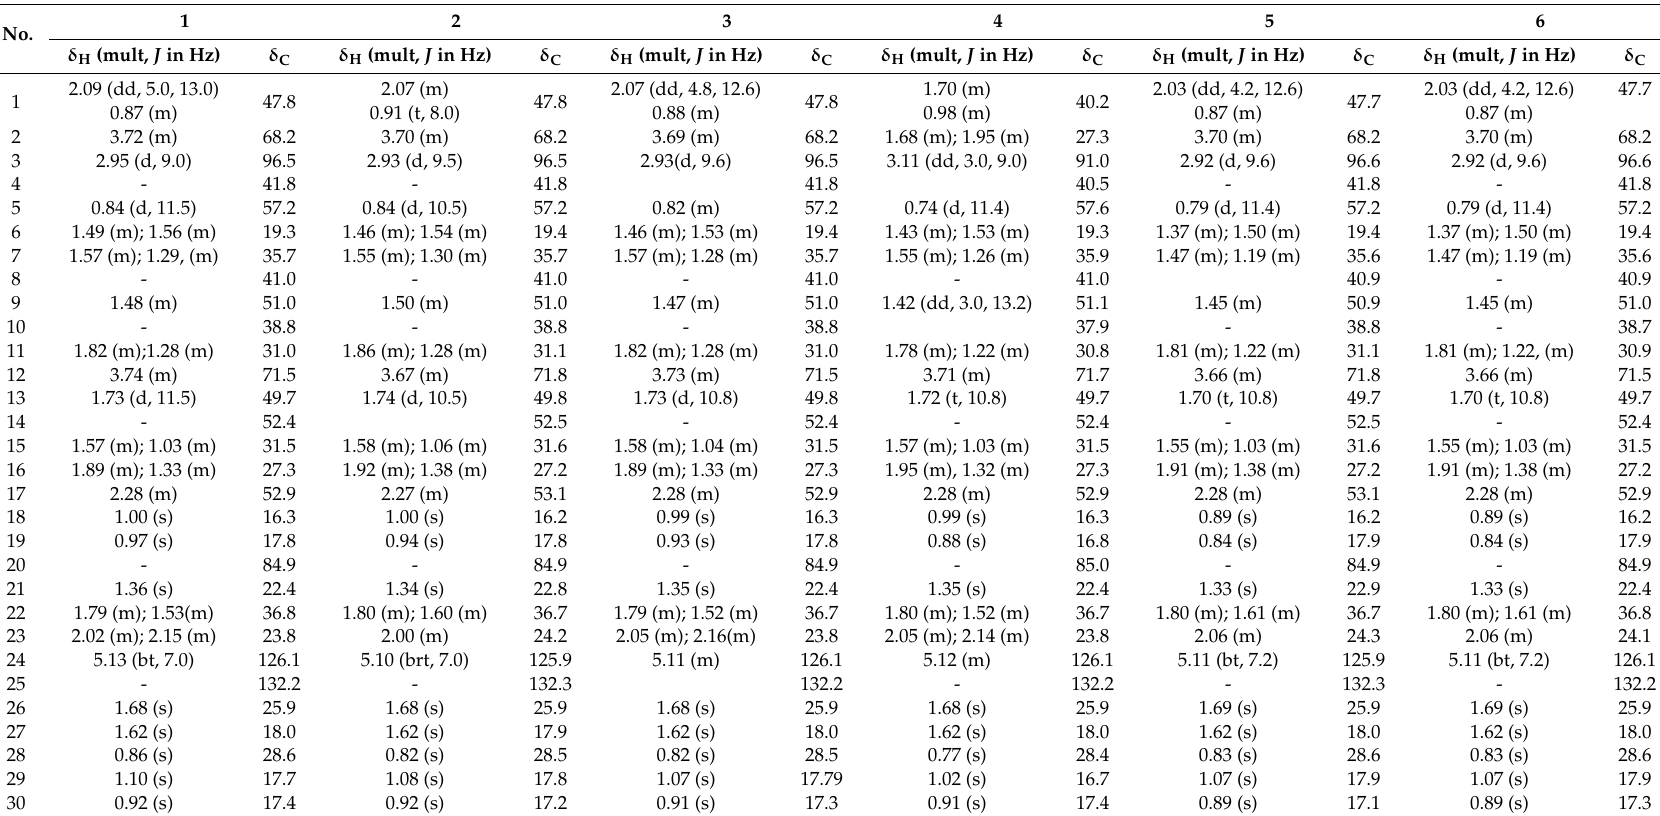
Table 1. 1 H- and 13 C-NMR spectroscopic data of the aglycone of gypenosides CP1-6 ( 1 – 6